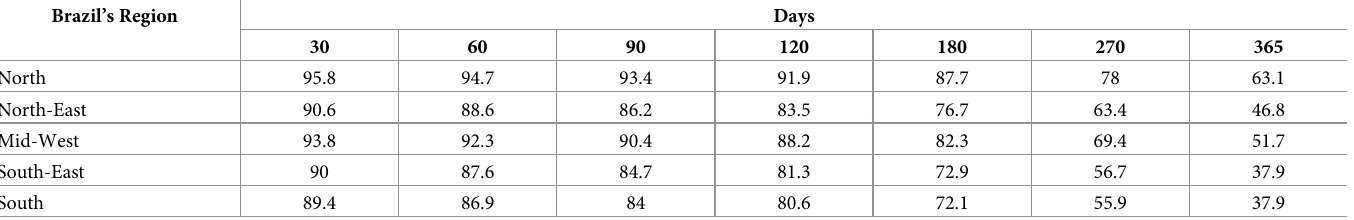
Table 1. Probabilities of children being breastfed according to age in days in different Brazil’s regions according to the Brazilian Ministry of Health (Ministe´rio da Sau´de do Brasil, 2009). [15]. Brazil’s